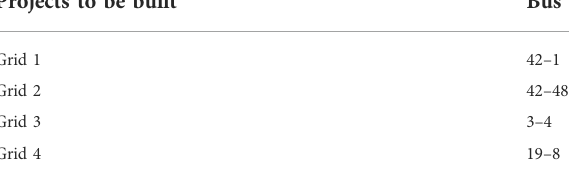
TABLE 2 Basic data of projects to be built on the grid side. Projects to be built